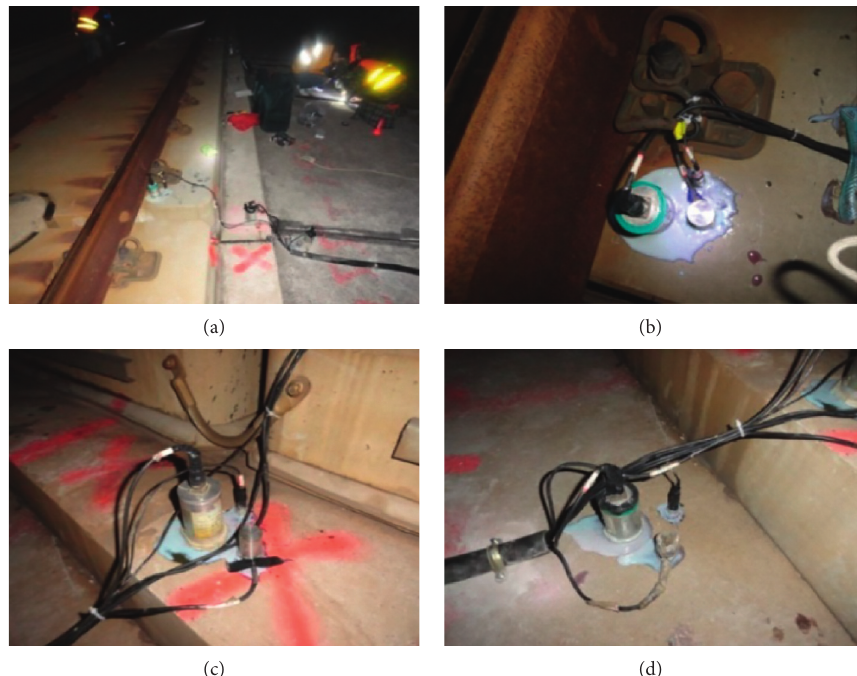
Figure 5: Test sensors installation on the Shanghai-Nanjing railway line [32]. (a) Overall view. (b) On the slab layer. (c) On the base layer. (d) On the roadbed